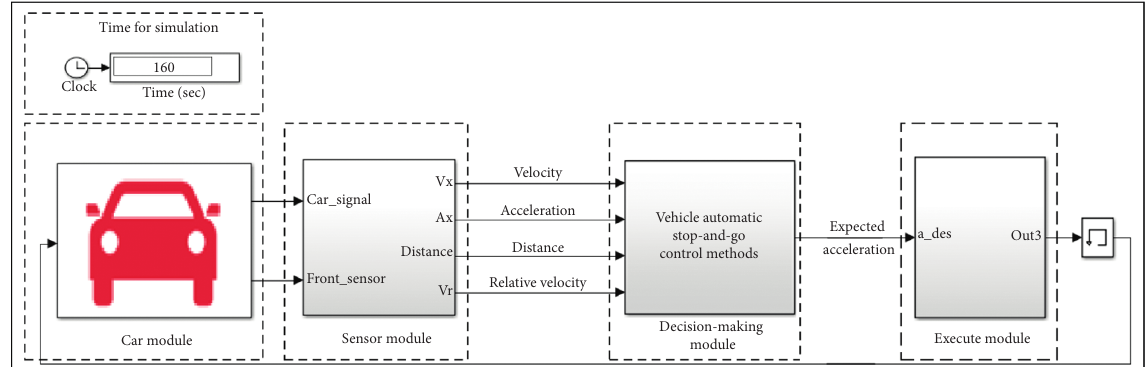
Figure 10: The vehicle longitudinal automatic control model based on MATLAB/SIMULINK.